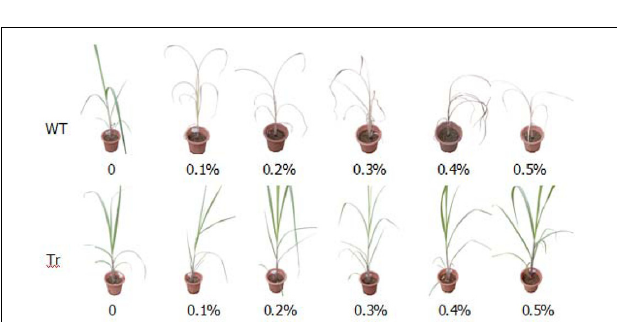
FIGURE 5 | Glyphosate tolerance testing of single-copy transgenic lines. WT: Sugarcane clonal propagation from the wild-type line; Tr: Sugarcane clonal propagation from single-copy transgenic lines. The transgenic clonal grew healthy even when treated with up to 0.5% roundup while wild type clonal would die off when treated with 0.1% roundup.